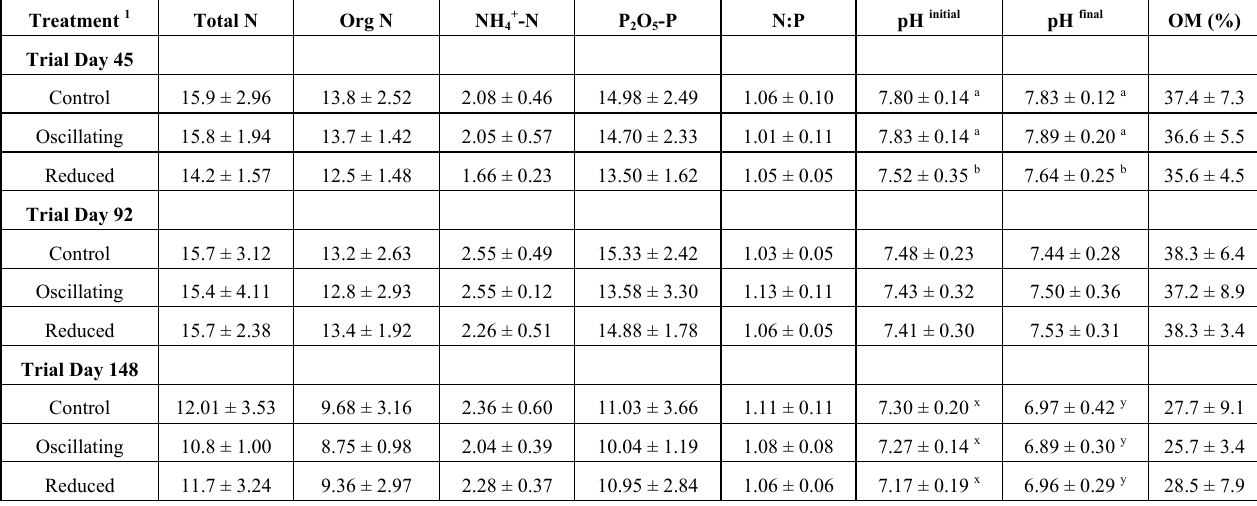
Table 1. Summary of pen surface chemical analysis (g·kg − 1 , except where